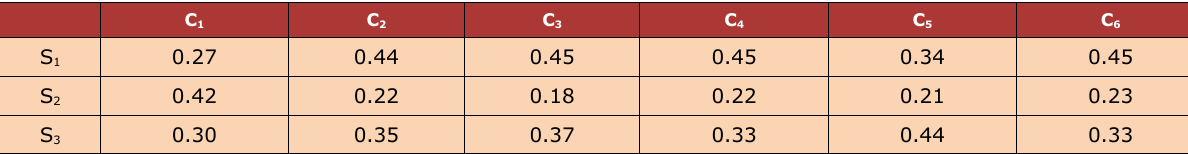
Table 3. Normalized decision